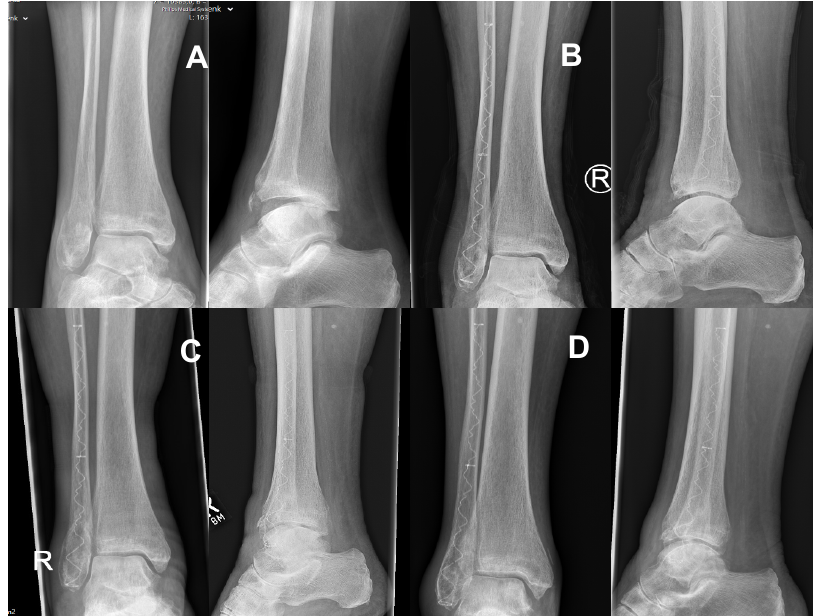
Figure 7. Radiograph of a 77-year-old female patient with an AO type 44 B1.1 (( A ) a preoperative) fracture treated with the IlluminOss ® Photodynamic Bone Stabilization System. Postoperative results after 6 ( B ) and 12 weeks ( C ) as well as after 14 months ( D ) showed excellent fracture healing.